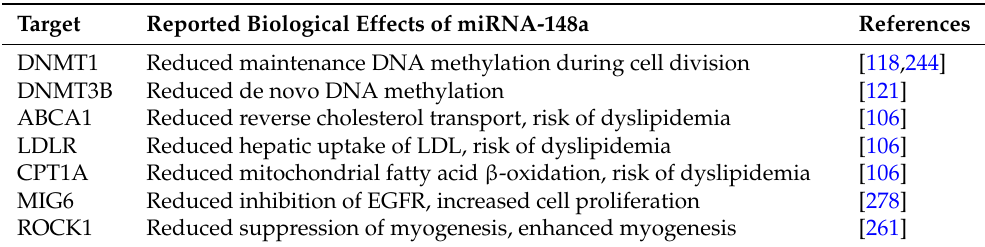
Table 4. Selected target mRNAs of